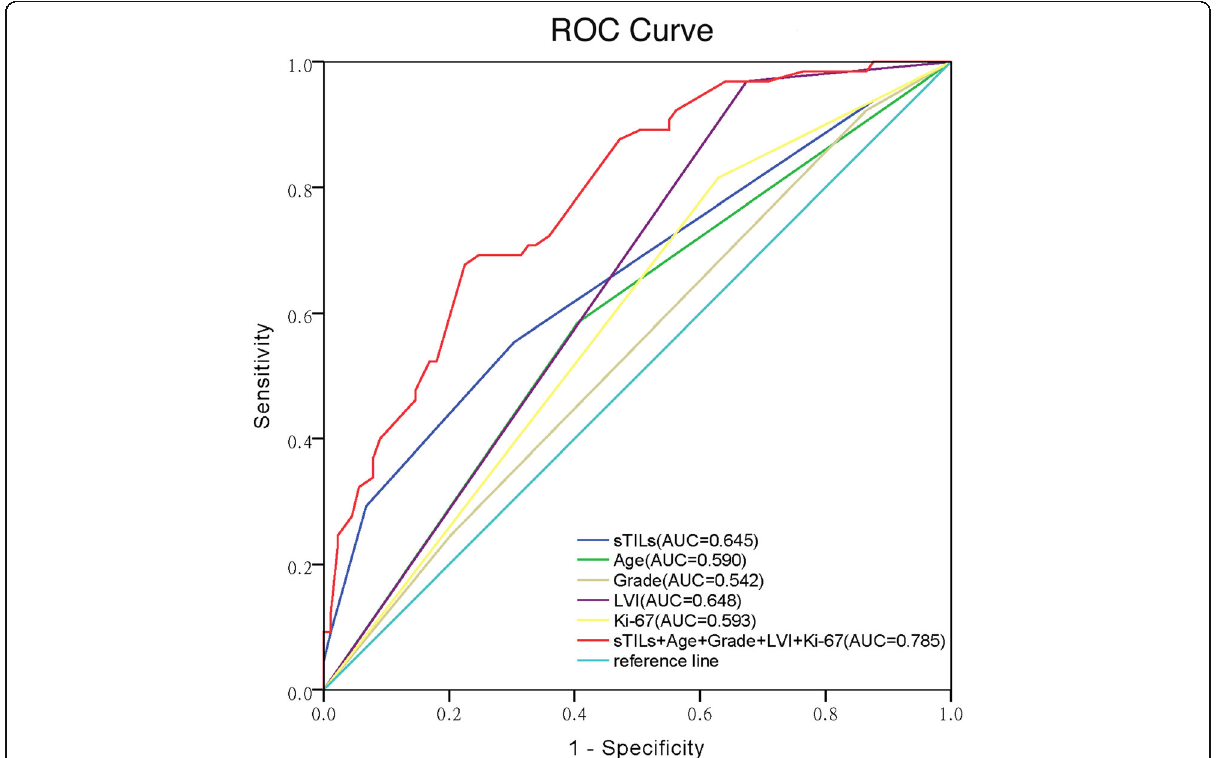
Fig. 4 Receiver operating characteristics (ROC) analysis for the combination of sTILs with clinicopathologic parameters (patients ’ age, histological grade, LVI and Ki-67 index) to predict pCR in TNBCs. The AUC (area under the curve) were listed in the picture. 95% confidence interval (CI) of combined predictive model was 0.714 – 0.856 ( P = 0.0001), sTILs: 95% CI 0.575 – 0.747 ( P = 0.0001), patients ’ age: 95% CI 0.499 – 0.681( P = 0.057), histological grade: 95% CI 0.450 – 0.634 ( P = 0.373), LVI: 95% CI 0.562 – 0.733 ( P = 0.002), Ki-67: 95% CI 0.503 – 0.683 ( P =